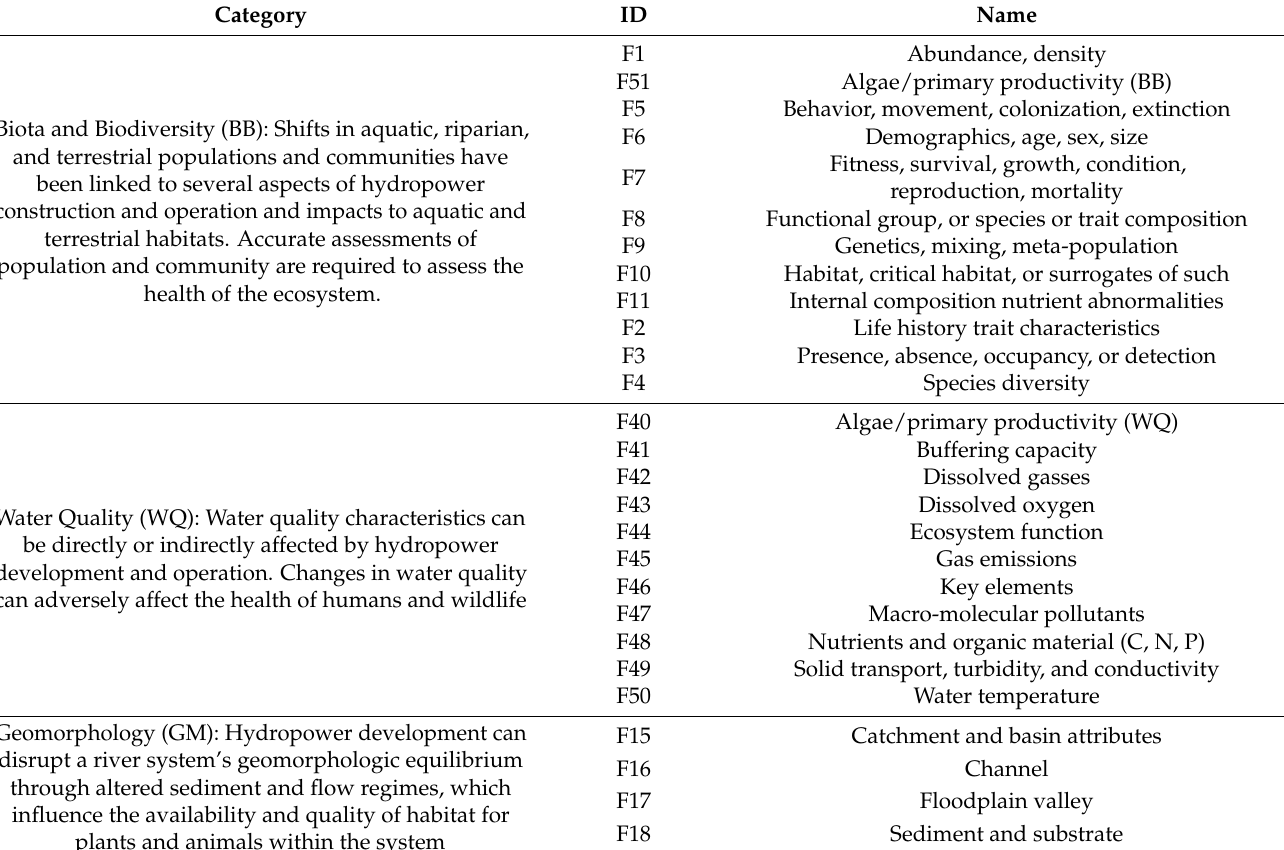
Table 1. River function indicators used to develop the science-based questionnaire presented in this paper (indicators and table taken and modified from Parish et al., 2019; Pracheil et al., 2019 and McManamay et al.,